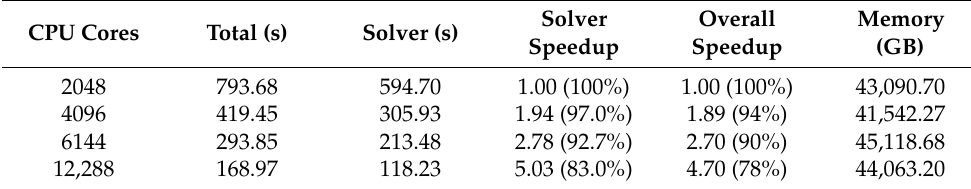
Table 15. Summary of Example